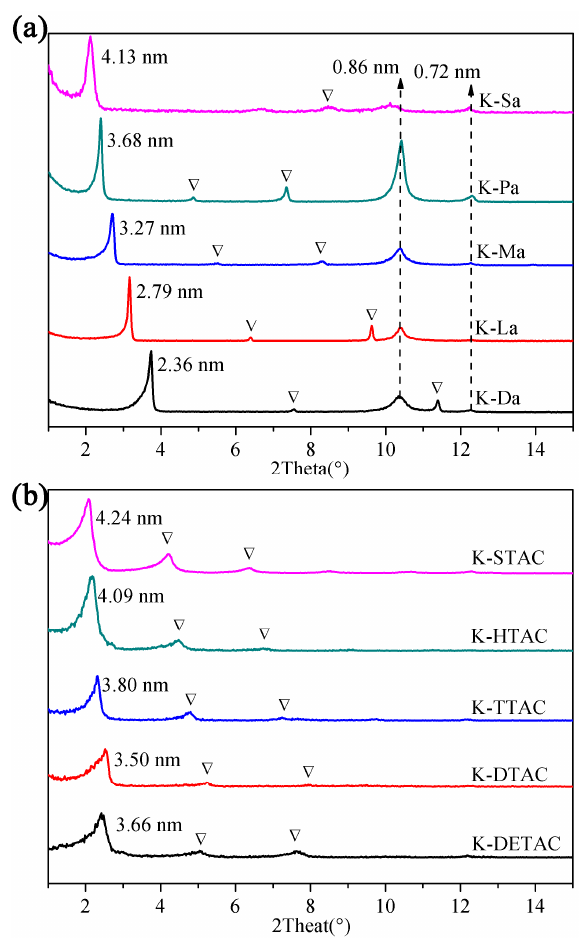
Figure 1. XRD patterns of ( a ) kaolinite/fatty acid intercalation compounds (K-Fas) and ( b ) kaolinite/quaternary ammonium salts intercalation compounds (K-Qas). Table 1. Basal spacing values (d 001 ), expansion of d-spacing Δ d of different kaolinite intercalation compounds, and molecular chain length of intercalated guest species.